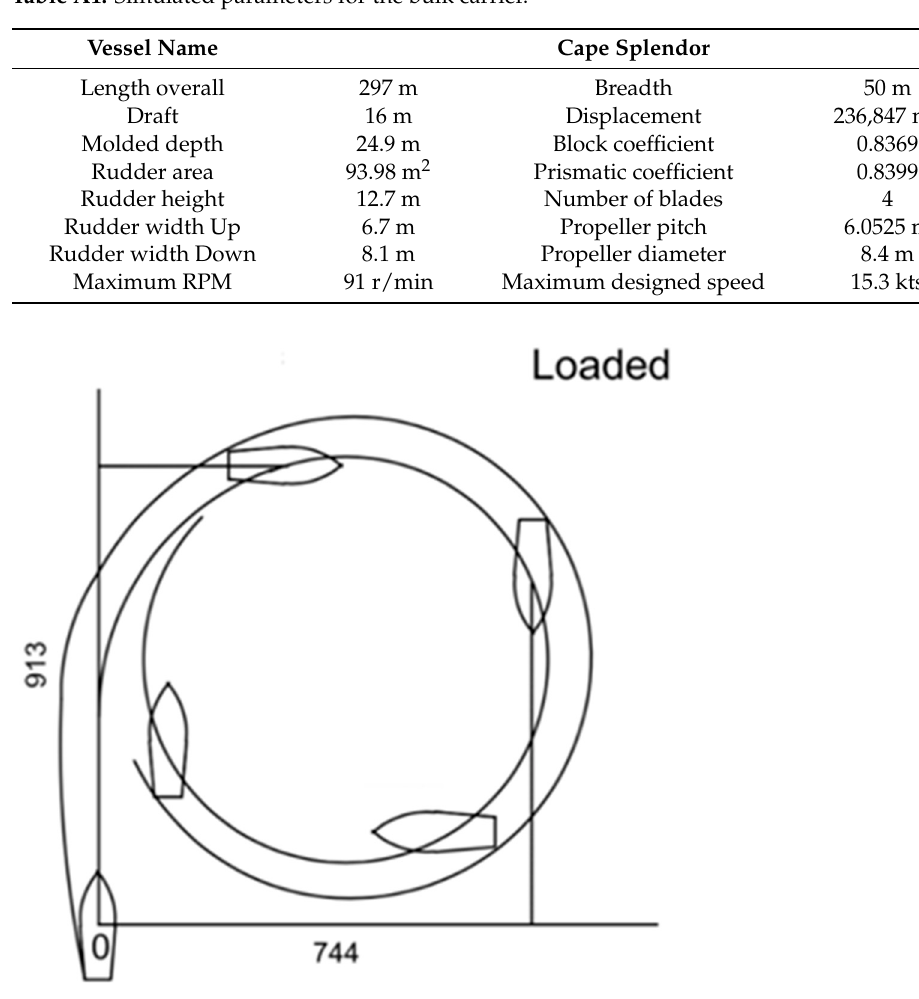
Figure A1. Turning circle at maximum rudder angle (sea trail).